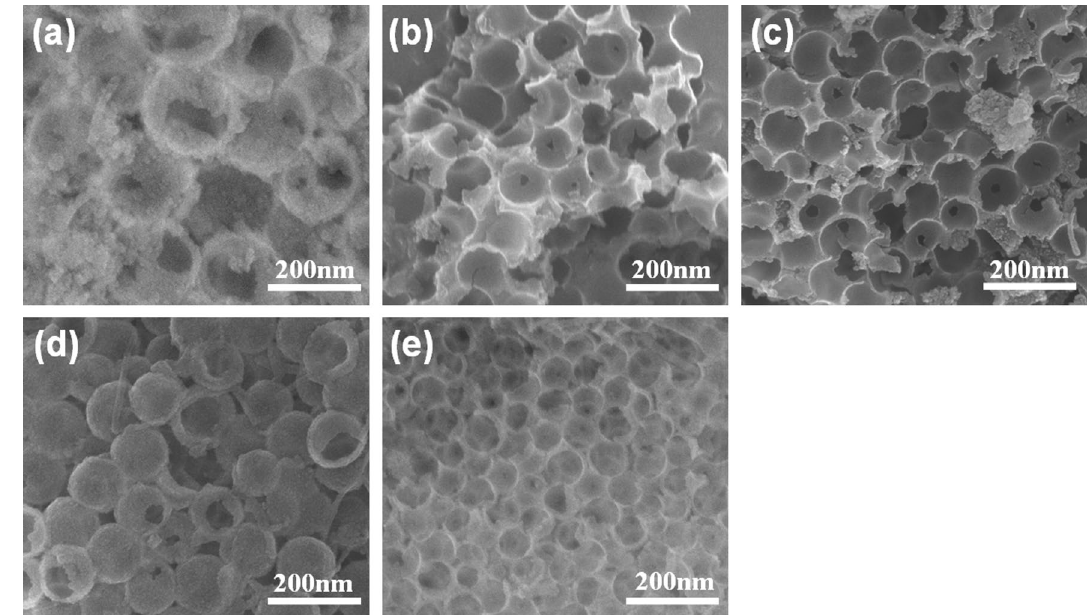
Figure 3. SEM graphs of HPP with various hypercrosslinking time ( a ) 3 h; ( b ) 6 h; ( c ) 12 h; ( d ) 18 h; ( e ) 24 h.